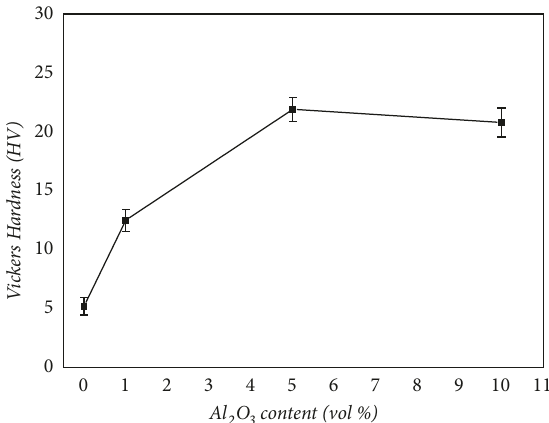
Figure 8: Hardness of polyester/alumina composites at different alumina